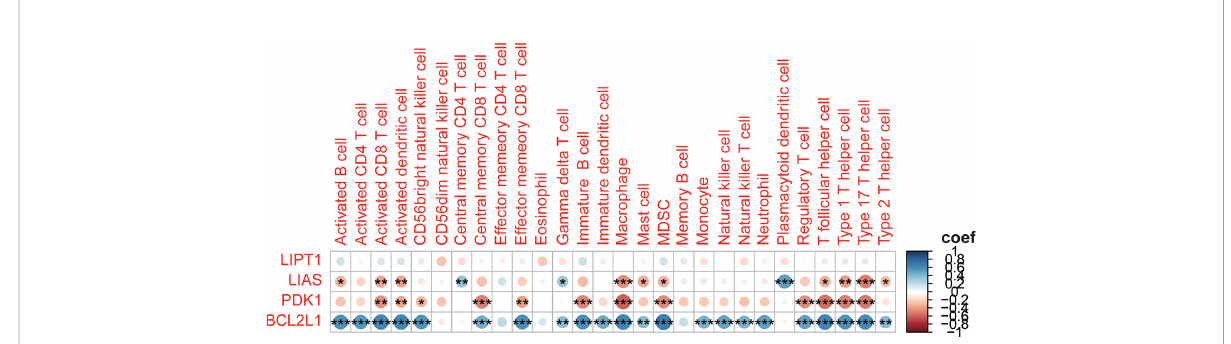
FIGURE 9 Correlation between the 4 CRGs and immune cell in fi ltration. *p<0.05; **p<0.01;